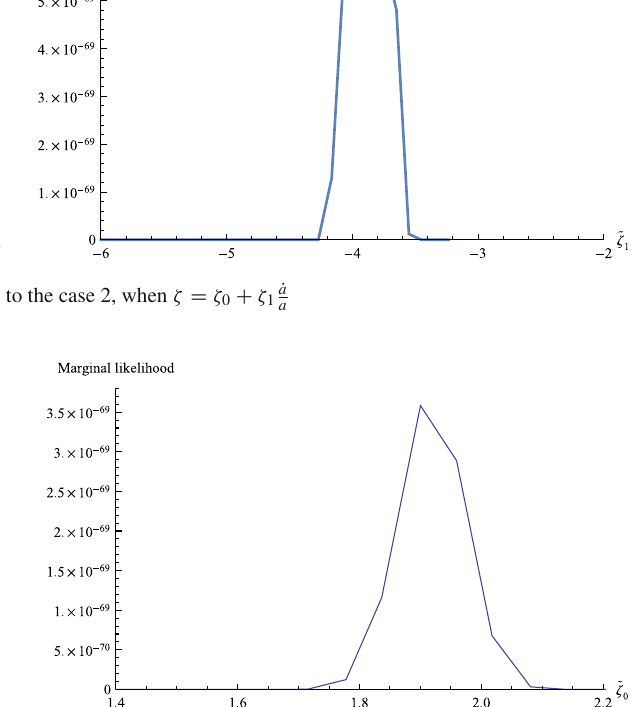
Fig. 3 Marginal likelihood of the parameter ˜ ζ 0 corresponding to the case 3, when ζ = ζ 0 , a